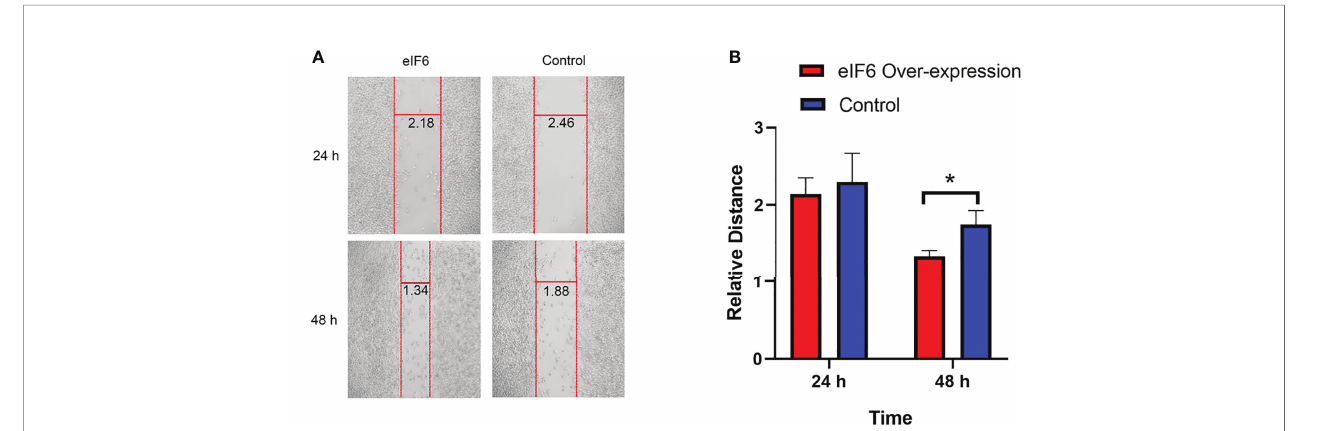
FIGURE 4 | Wound healing assay measures the migration of melanoma cells with over-expression of eIF6. (A) The vertical red lines show the wound edges at 24 h and 48 h after scratching, and the horizontal lines show the relative distances between red stripes at the same observation times. The eIF6 over-expression cells migrated more quickly than the control group. (B) The spaces between wound edges were measured, and the values were signi fi cantly lesser than the eIF6 over- expression group after incubation for 48 h. The signi fi cance test of change was evaluated with P value. P value < 0.05 was labeled as “ * ” . P-value < 0.01 was labeled as “ ** ” . P-value < 0.001 was labeled as “ *** ” .